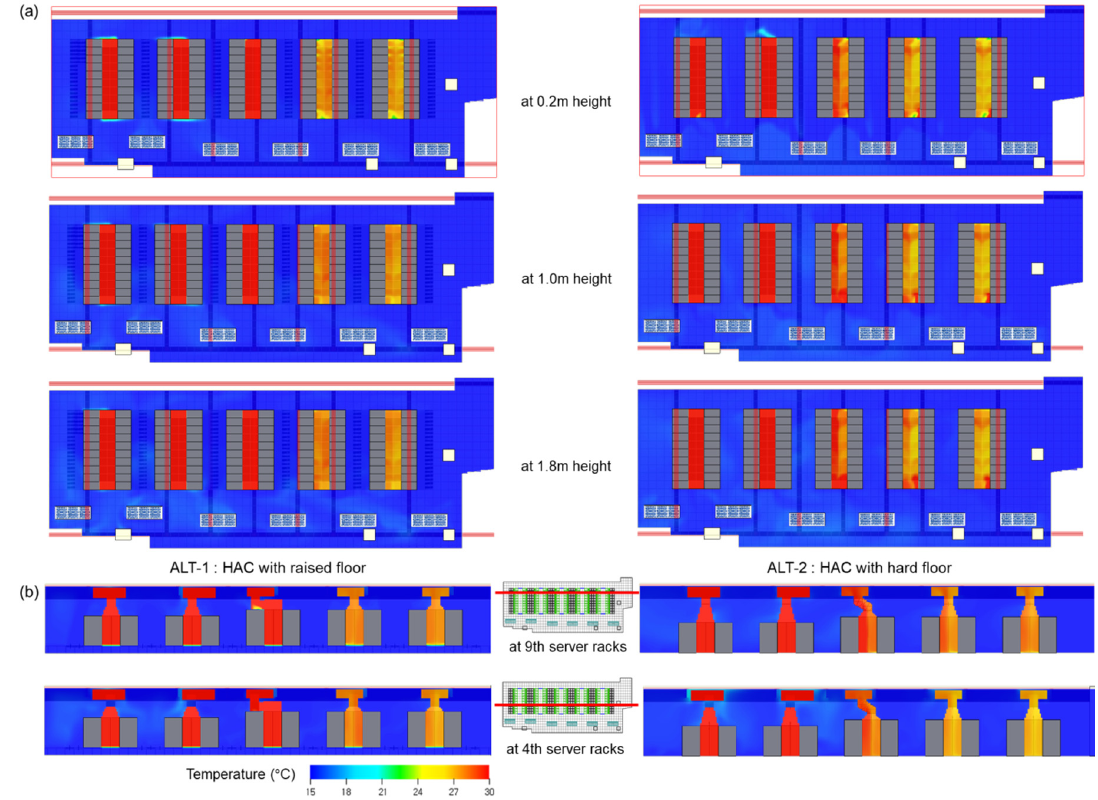
Figure 6. Contours of temperature in normal cooling condition; ( a ) a horizontal section view and ( b ) a vertical section view.